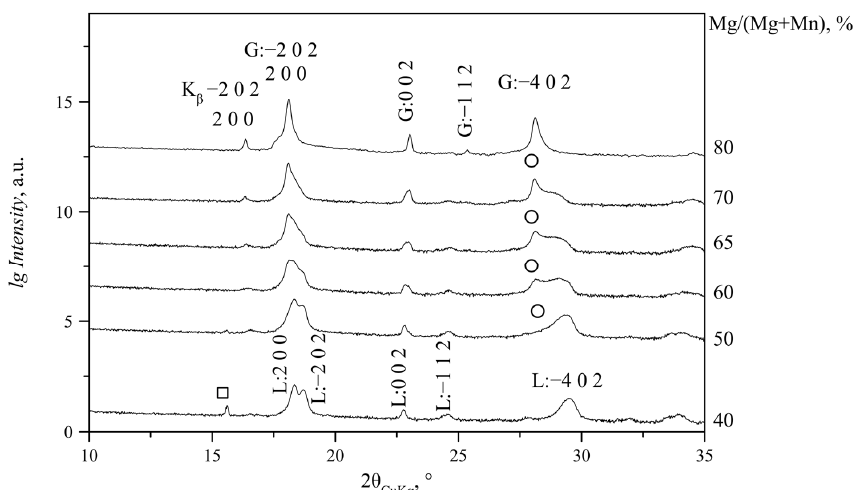
Figure 4. PXRD patterns of precipitates obtained at Mg/(Mg + Mn) = 40–80% (S series, 2 θ CuK α = 10–35°). Notation: L—solid solution with lindbergite structure; G—solid solution with glushinskite structure; □ —peak of MnC 2 O 4 ∙ 2H 2 O phase (sp.gr. P 2 1 2 1 2 1 ); ○ —peak indicating formation of solid solution with glushinskite structure.